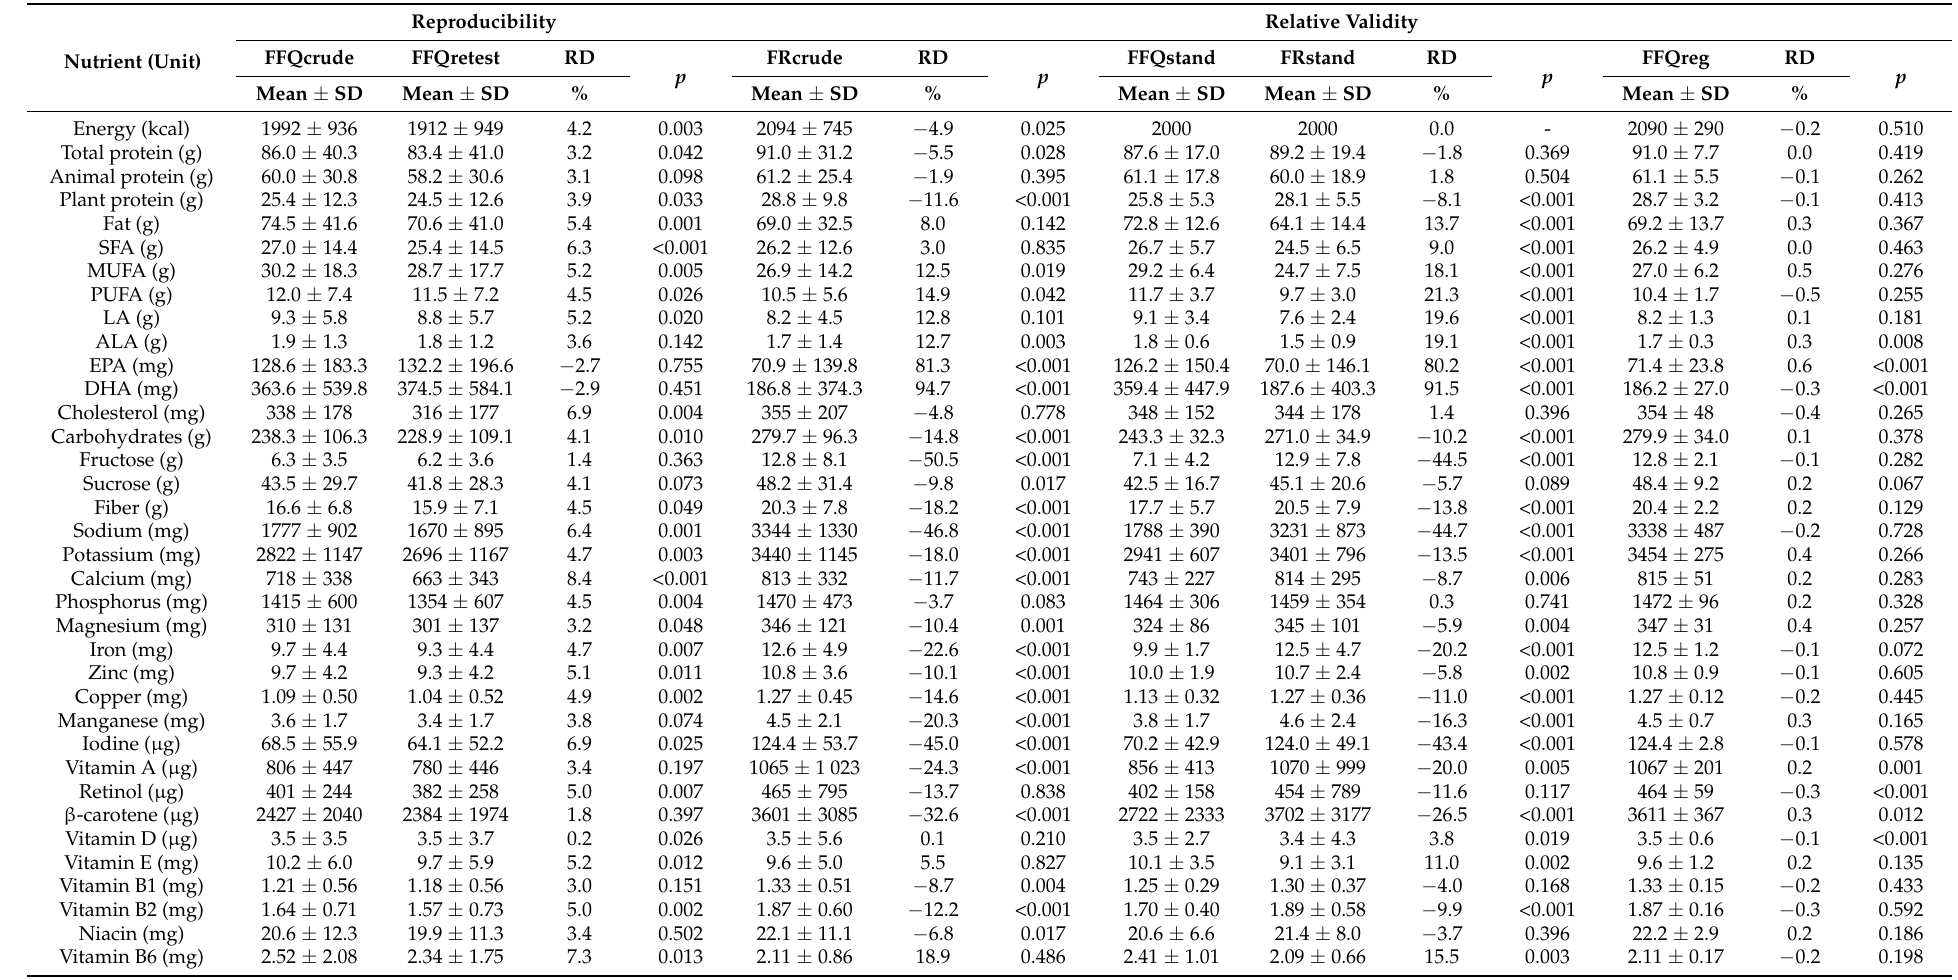
Table 2. Comparison of the mean daily energy and nutrient intake obtained with the 72-item SQ-FFQ and estimated food record (FR) among Polish young adults ( n =